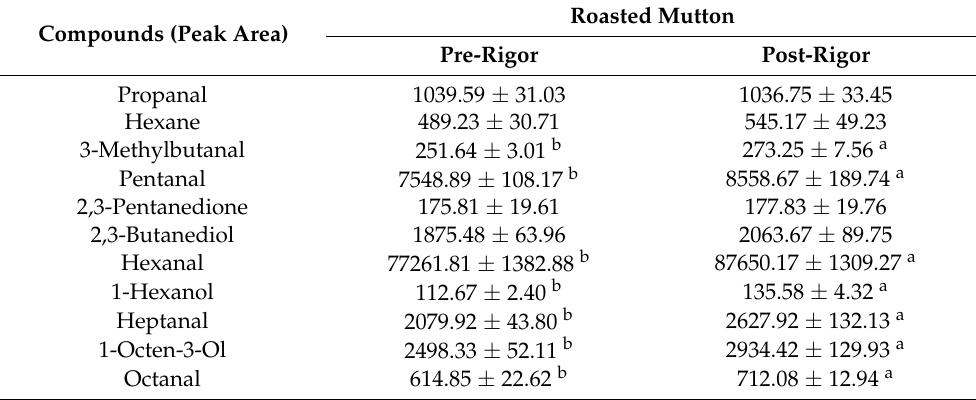
Table 4. Peak areas of aroma compounds detected by flash GC e-nose in the pre- and postrigor roasted mutton.